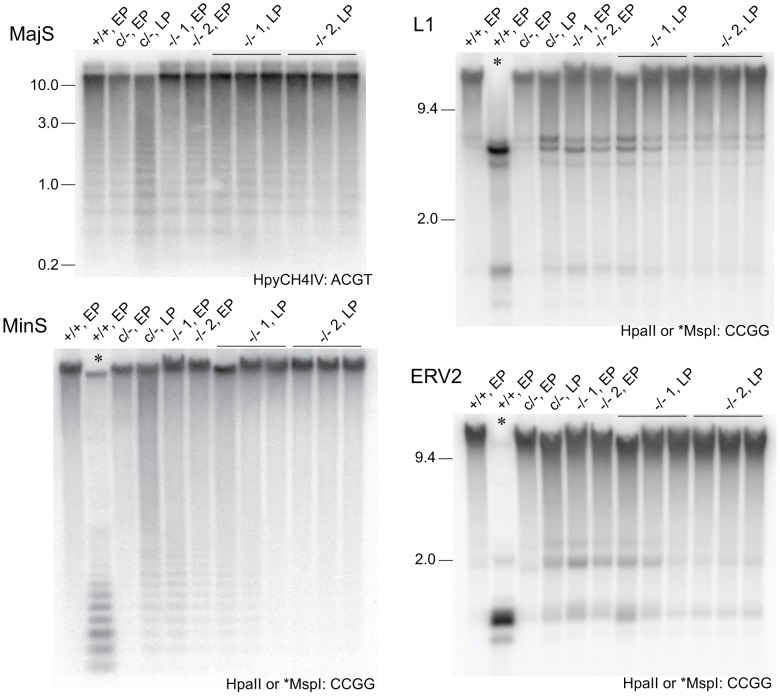
Stability of DNA methylation in DICER1-deficient ES cells.Methylation-sensitive Southern blots. Details are provided in the legend to Figure 1, except that later passage (LP) cells were also used. Passage (p) numbers were: +/+, EP (p8), c/−, EP (p7), c/−, L (p24), −/− 1, EP and −/− 2, EP (p5), −/− 1, LP and −/− 2, LP (p20). Generally, a single passage for +/+ and c/− lines lasted 3 days, while for −/− cells a single passage lasted 5 days. The restriction enzyme and its recognition sequence are at the bottom right of each plate. At CCGG sites, HpaII cuts only when the CpG dyad is unmethylated. The isoschizomer MspI can cut when the CpG dyad is fully, hemi- or unmethylated.